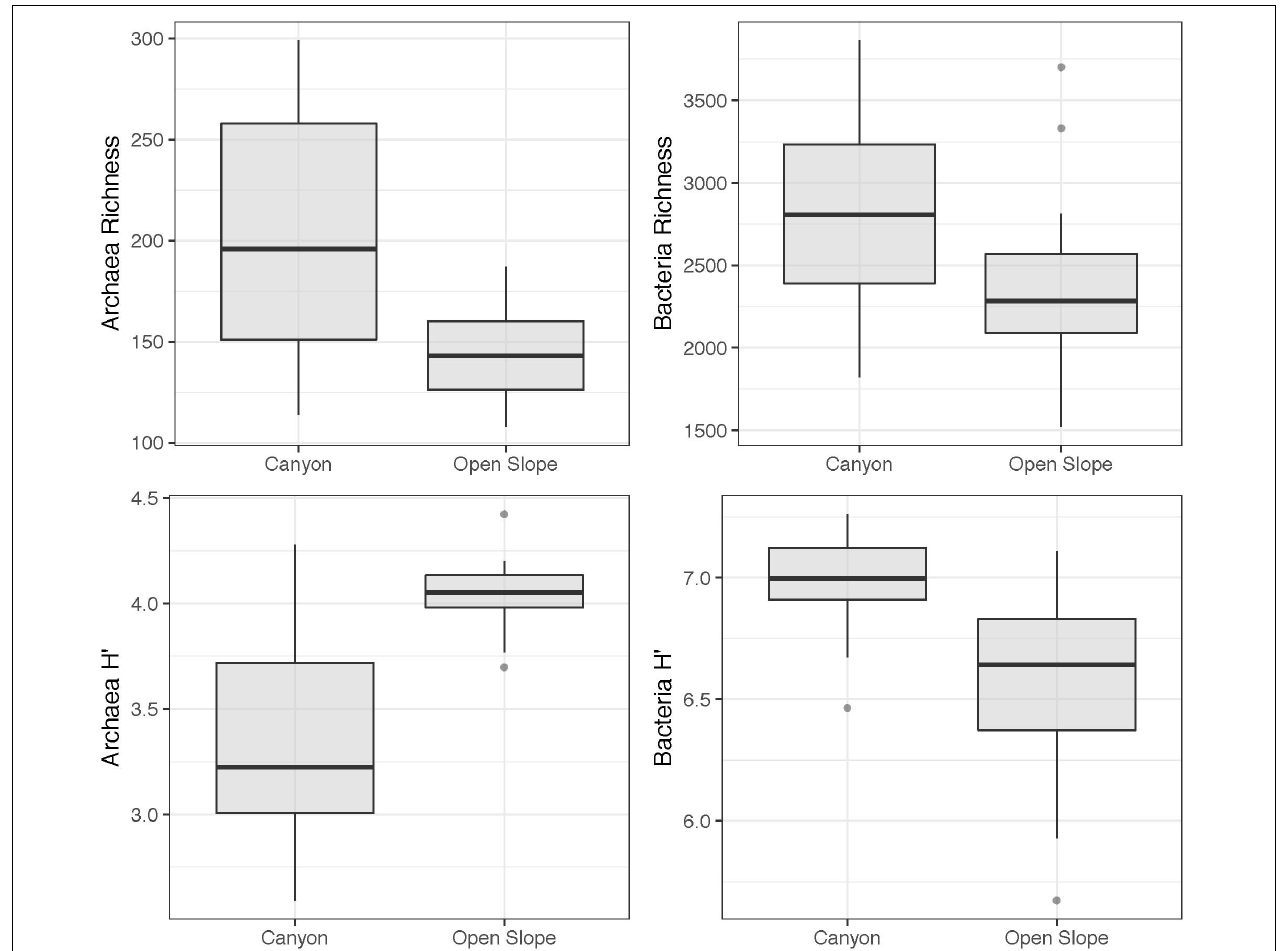
FIGURE 6 | Alpha diversity of Archaea and Bacteria measured as Richness (OTU number) and Shannon index (H (cid:48) ).